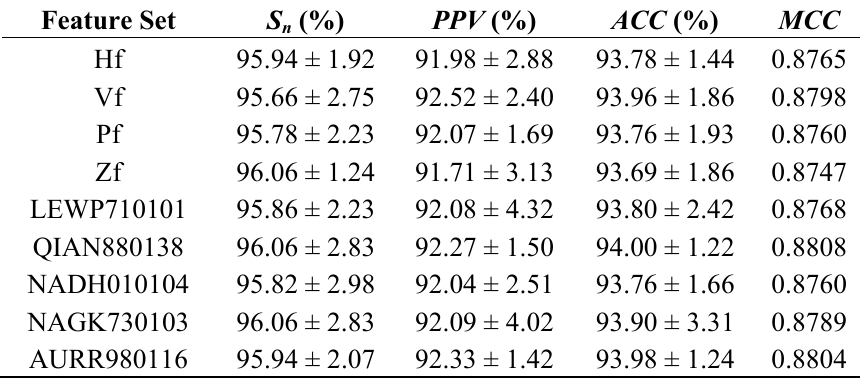
Table 1. Results of DFPCA and AAID with PRBF SVM in 10 CV